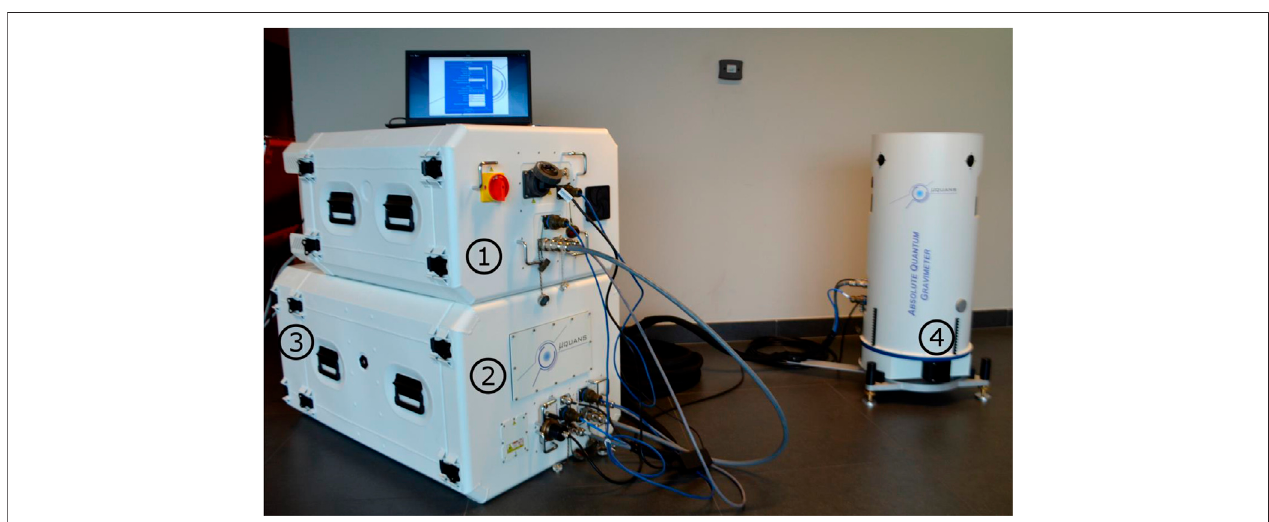
FIGURE 7 | Field version of the AQG (AQG-B) in operation con fi guration. 1- Power supply unit. 2- Laser system. 3- Air-conditioning unit. This module can be separated from the laser system during transport. 4- Sensor head. Four cables and an optical fi ber connect the sensor head to the rest of the system, with a maximum separation of 15